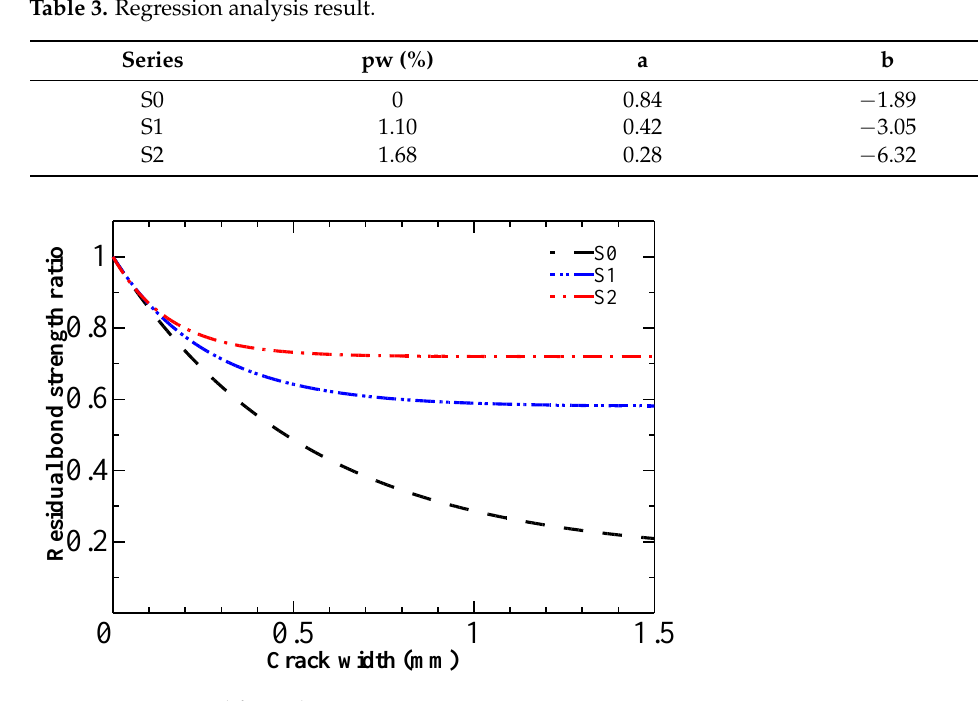
Figure 14. Proposed formulas comparison.